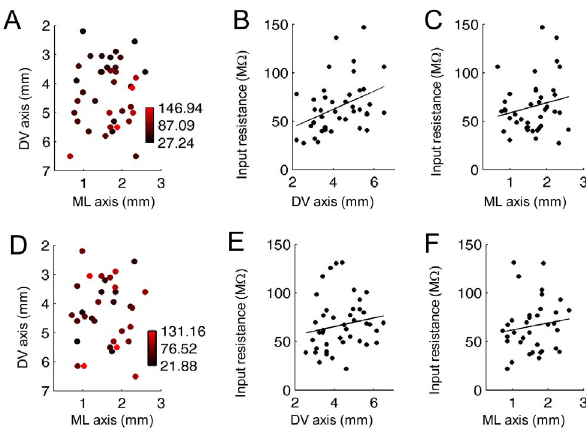
Figure 7. Input resistance systematically changes along the DV axis. (A) Color plot of the input resistance at different positions in the two-dimensions (DV and ML) of anatomical space in normal ACSF. (B and C) Input resistance along the DV and ML axis, respectively, in normal ACSF. (D) Color plot of the input resistance at different positions in the two-dimensions (DV and ML) of anatomical space in carbachol (10 m M). (E and F) Input resistance along the DV and ML axis, respectively, in carbachol.